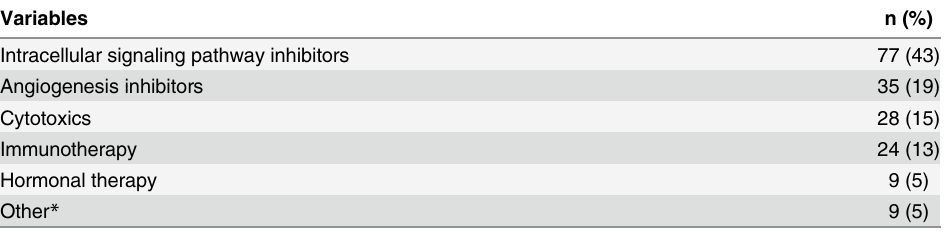
Table 2. Types of phase 1 clinical trials in which cases and controls were included.